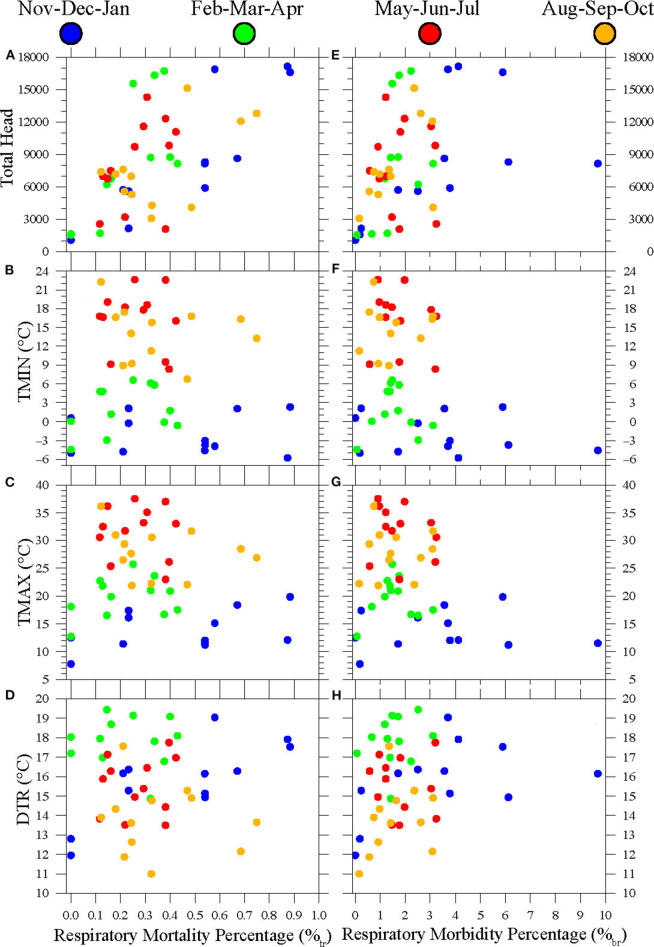
Scatterplots of (A) monthly respiratory mortality percentage (%tr) vs. monthly total head, (B) %tr vs. average monthly minimum temperatures (TMIN), (C) %tr vs. average monthly maximum temperatures (TMAX), (D) %tr vs. average monthly daily temperature range (DTR), (E) %tr vs. monthly total head, (F) monthly respiratory morbidity percentage (%br) vs. average monthly minimum temperatures (TMIN), (G) %br vs. average monthly maximum temperatures (TMAX), and (H) %br vs. average monthly maximum daily temperature range (DTR). All monthly head counts, %tr, and %br values were calculated across 19 feedyards within a 96.6-km radius of Hereford, Texas, during January 2015 to December 2018. All monthly temperature values were calculated from daily data from the Hereford Mesonet station.